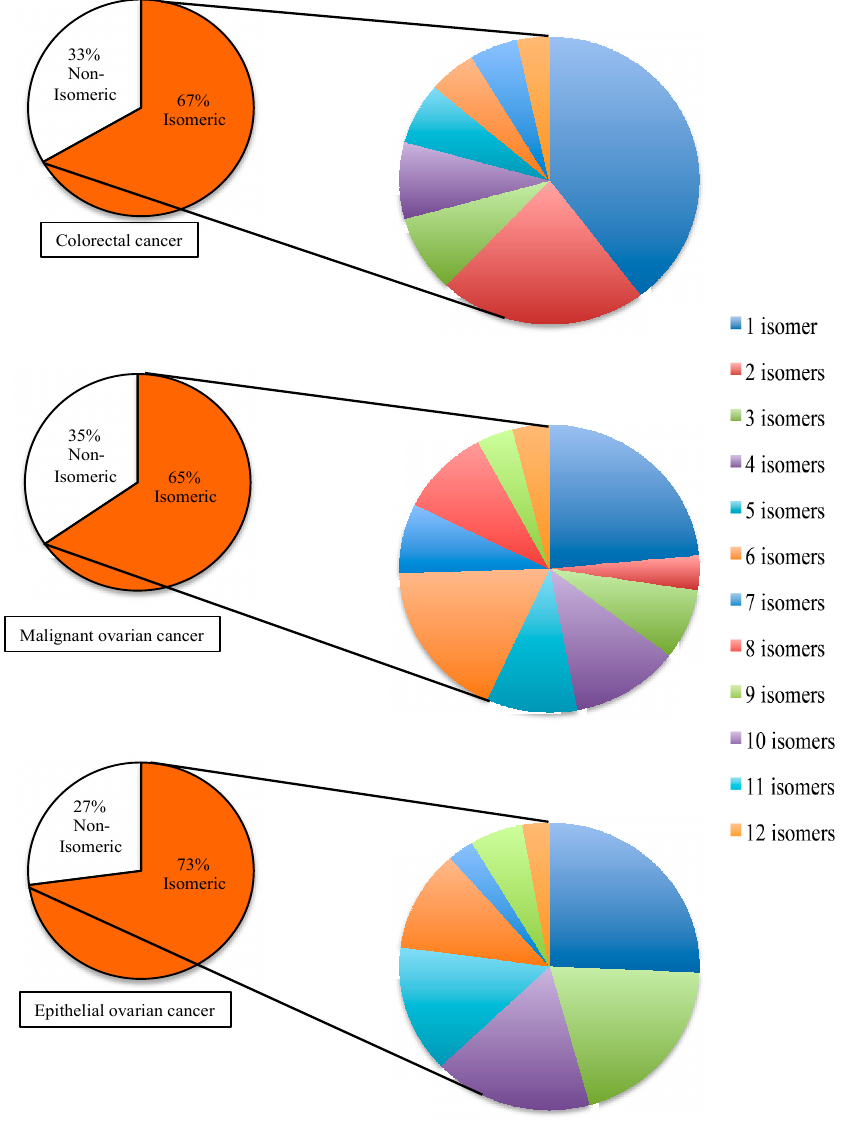
Figure 3. Isomerism of microRNA in selected disease models. The disease ‐ associated microRNAs are categorized by the selected diseases. In each disease model, a specific disease ‐ associated microRNA is defined as isomeric microRNA if its nucleotide composition is identical to another human microRNA. The percentages of isomeric disease ‐ associated microRNA are shown in the smaller pie charts on left hand side. The total number of disease ‐ associated microRNA in each case is different—colorectal cancer has 87 microRNA, malignant ovarian cancer has 78 microRNA, and epithelial ovarian cancer has 48 microRNA. For each selected disease, the isomeric disease ‐ associated microRNA are further subcategorized by the number of isomers that co ‐ exist among the human microRNA and the percentage distributions of each group of isomers are shown in the pie charts on the right hand side.